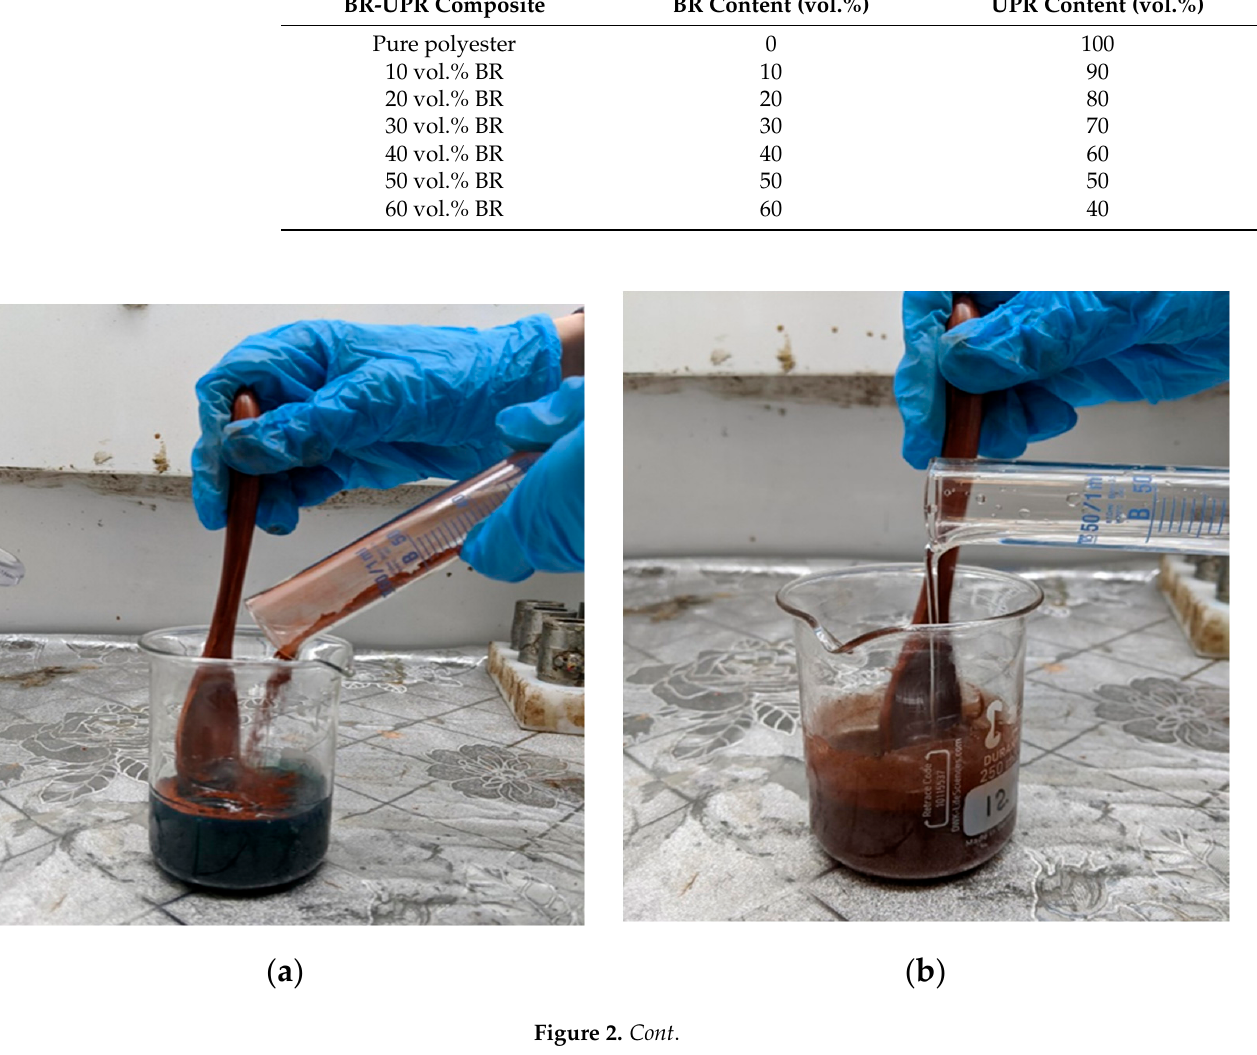
Table 2. Mix proportion of BR–UPR composites. BR-UPR Composite BR Content (vol.%) UPR Content (vol.%)